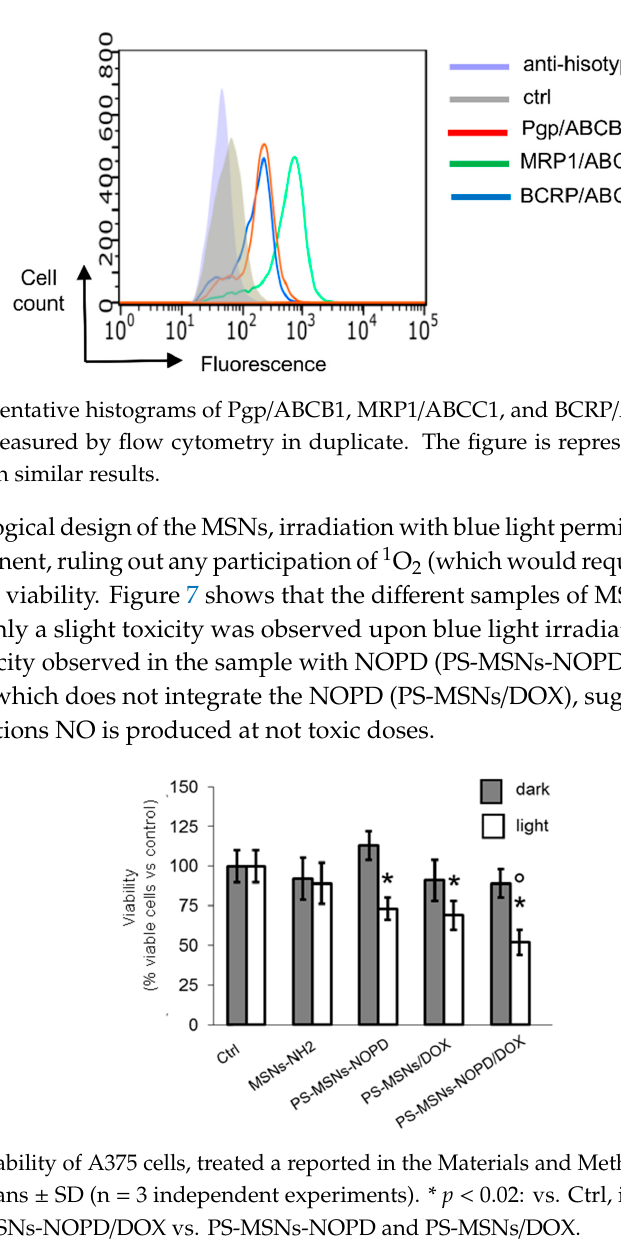
Figure 5. ( A ) A/A0 ratio at 440 nm of p -nitrosodimethylaniline/histidine (RNO) (17 µM) observed upon irradiation at 532 nm (50 mW) in the presence of different suspensions (1 mg mL − 1 ) of MSNs in PBS (pH 7.4, 10 mM). ( B ) NO release profile observed upon irradiation at 405 nm (100 mW) of different suspensions (1 mg mL − 1 ) of MSNs in PBS (pH 7.4, 10 mM). The inset shows the indirect e NO fluorimetric detection ( λ exc = 365 nm) (see experimental) observed for PS-MSNs-NOPD suspension (1 mg ml − 1 ) in the dark and after 10 and 20 min irradiation at 405 nm. ( C ) DOX release observed for PS- MSNs-NOPD/DOX suspension (1 mg mL − 1 ) in PBS (pH 7.4, 10 mM) at 37 °C.